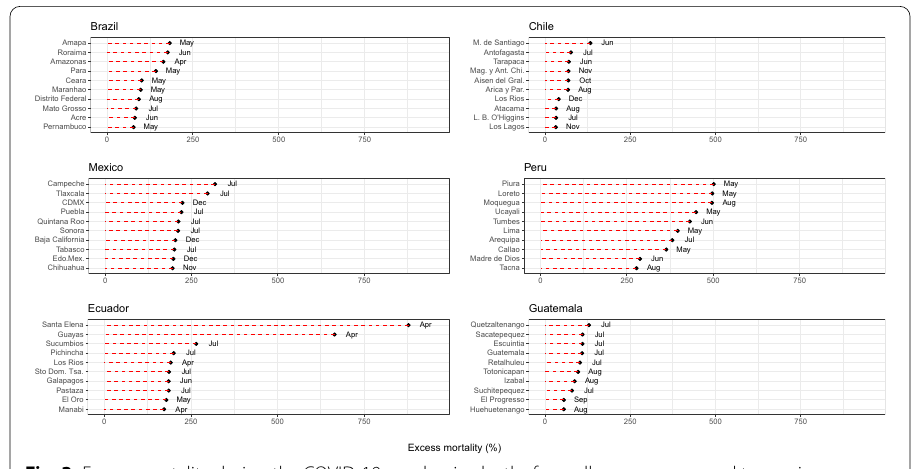
Fig. 3 Excess mortality during the COVID‑19 pandemic: deaths from all causes compared to previous years, all ages. The 10 highest values of excess mortality in regions of Latin American countries in 2020. Source: Ministry of Health, Brazil, Chile, and Peru, 2021; National Civil Registry Ecuador (Gobierno de la República del Ecuador, 2021); National Registry of Persons Guatemala (RENAP, 2021); and Secretariat of Health, Mexico (DGE‑SS, 2021). Names and acronyms of countries are presented in Additional file 4: Table